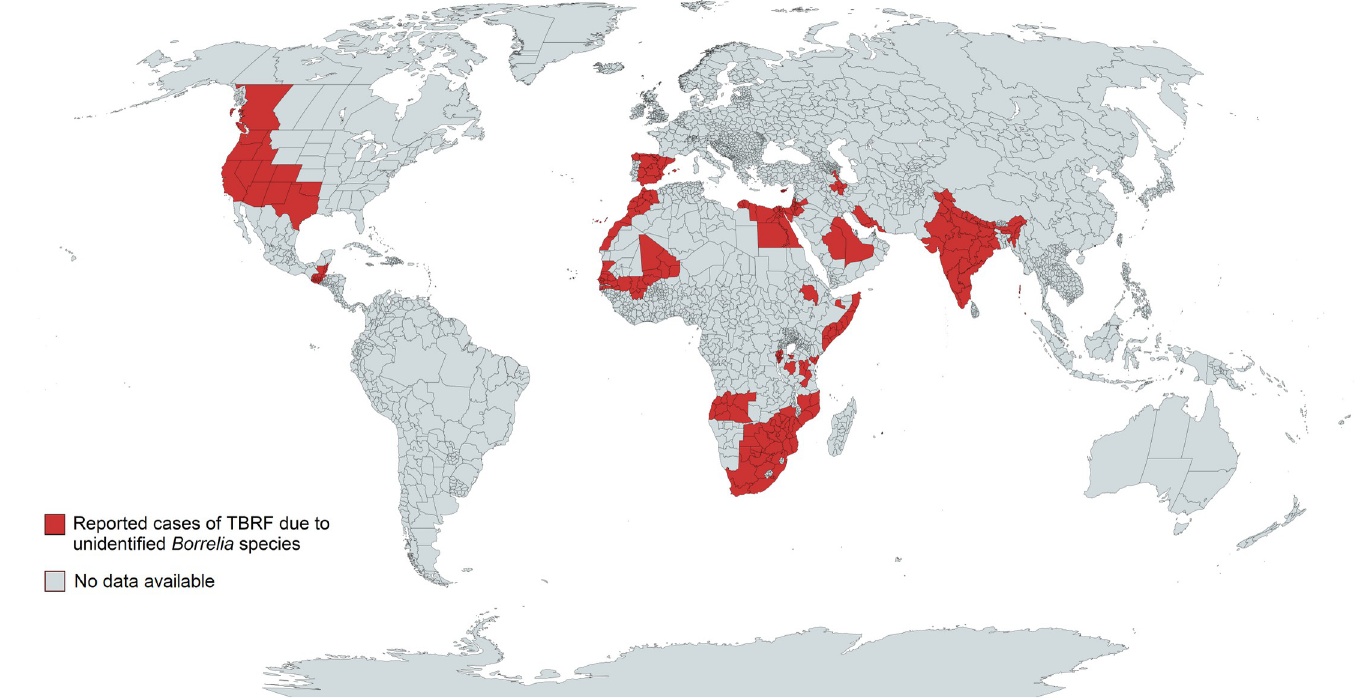
Fig 6. Reported TBRF cases caused by unidentified Borrelia species. TBRF, Tick borne relapsing fever. Map created on www.mapchart.net.